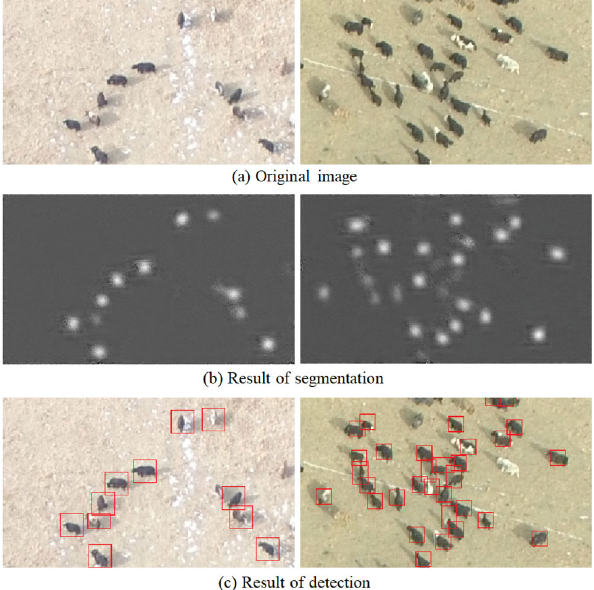
Fig. 6 Processing example images from segmentation to detection.